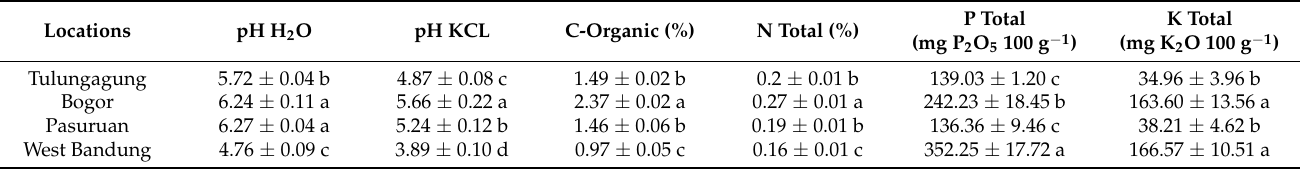
Table 4. Macronutrient status (C-organic, N, P, K) and pH values of soil samples under the kaffir lime canopy in four locations.